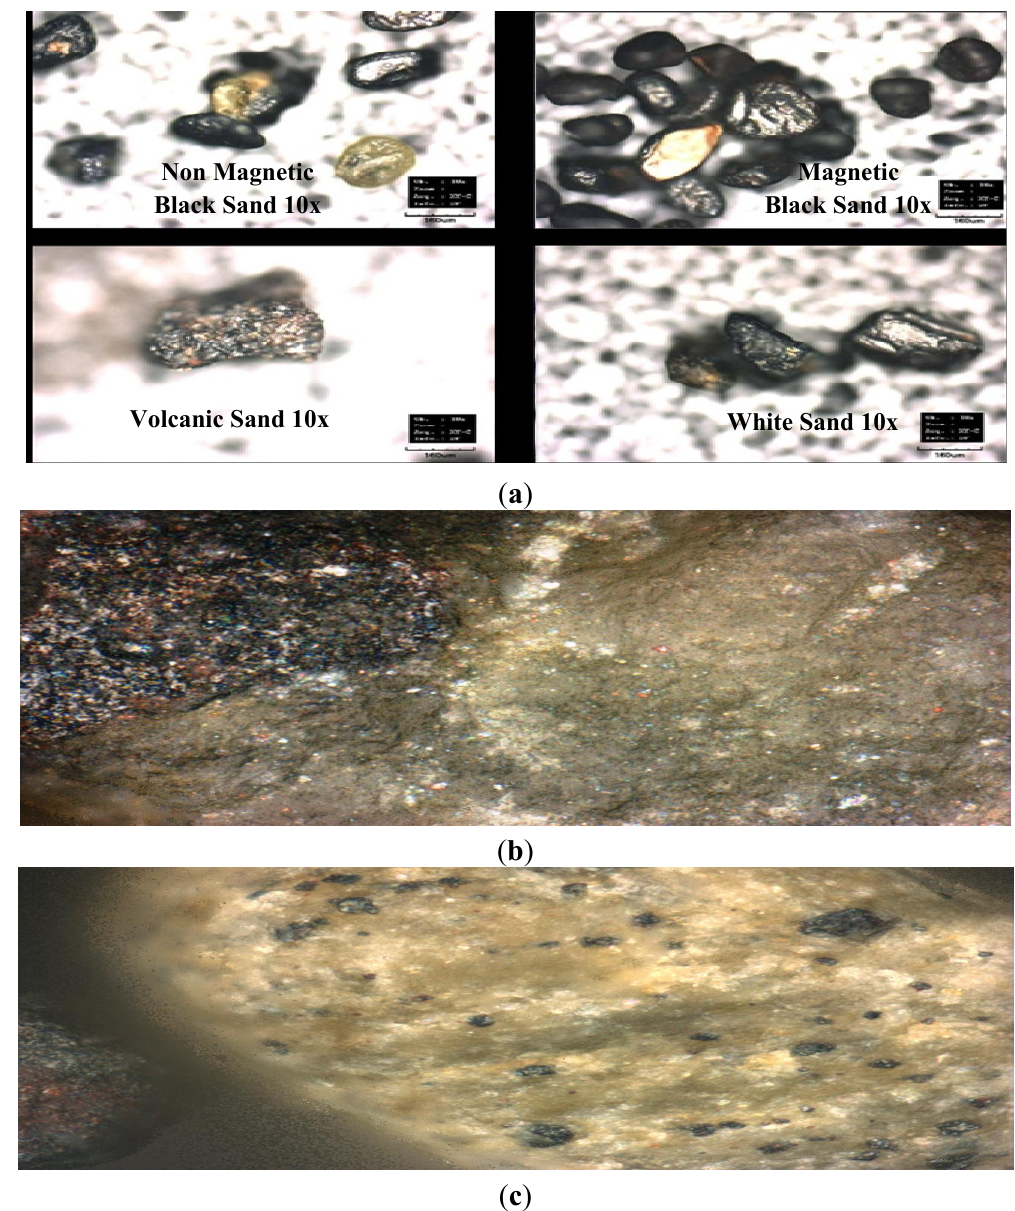
Figure 5. LSM images ( a ) sand (10× magnification); ( b ) magnetic black sand (100× magnification); and ( c ) white sand (100×